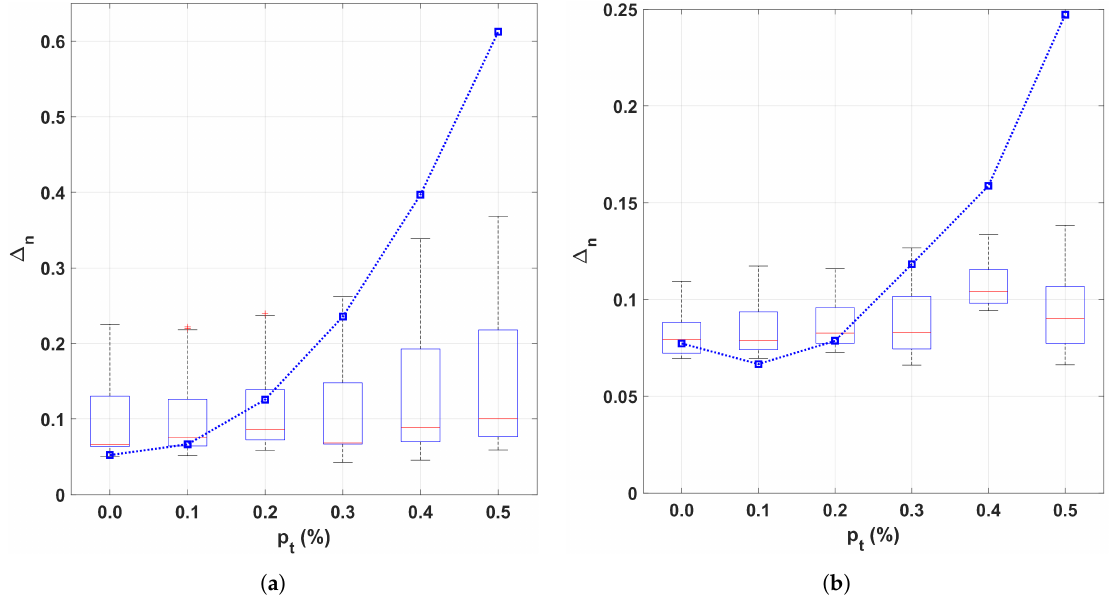
Figure 2. Comparison between the sensor-aware probability density function (PDF) wind models (boxplots using different values of ˆ σ ν , and ˆ σ θ ) and standard airflow mixture models (dashed blue line). The Cramer–Von Mises criterion is used as evaluation metric). ( a ) Wind direction. ( b ) Wind